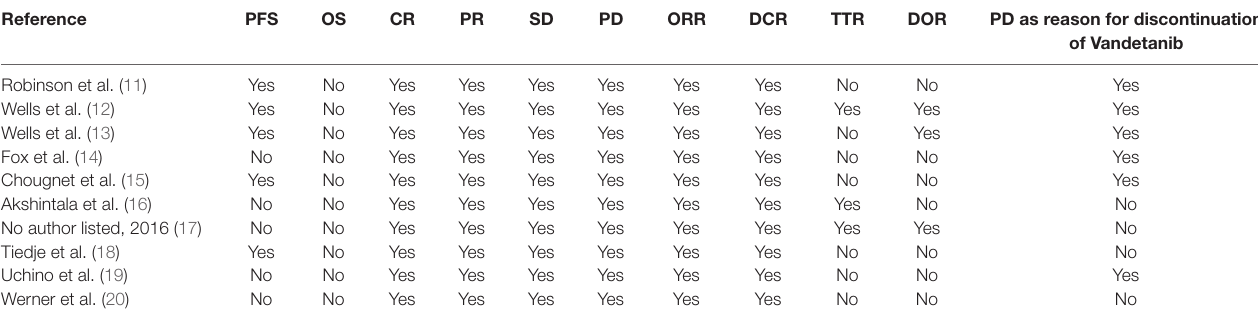
taBLe 2 | Data available in the included studies and extracted from the